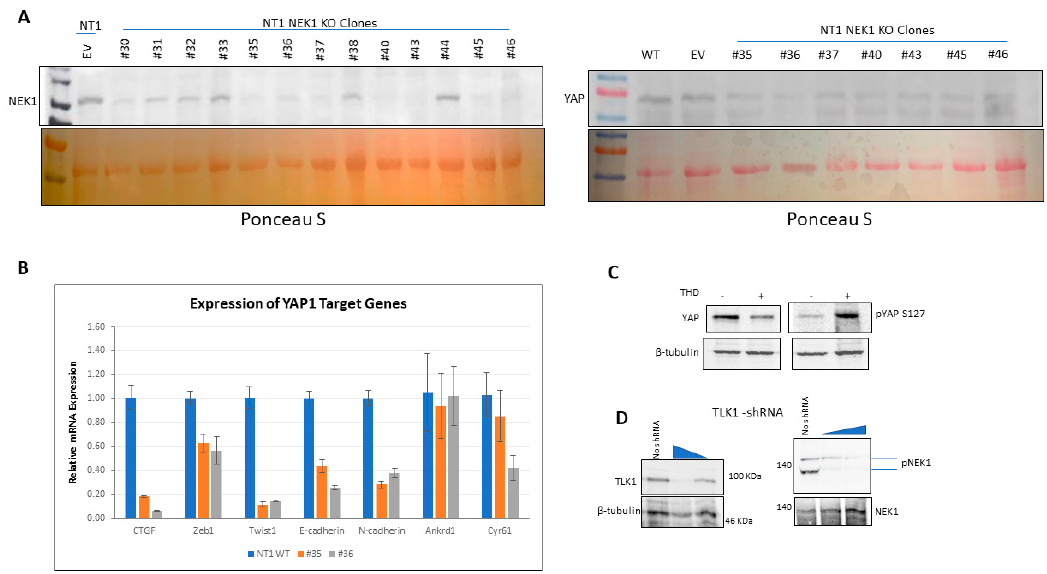
Figure 2. ( A ) CRISPR / Cas9-mediated loss of NEK1 resulted in reduced levels of YAP protein, possibly due to instabilization (EV = empty vector). ( B ) Expression of several typical YAP target genes is reduced in NEK1 KO clones. GAPDH mRNA was used as an internal control. ( C ) Treatment of LNCaP cells with THD, a specific inhibitor of TLKs, resulted in reduced YAP protein level and conversely in its S127 hyperphosphorylation. ( D ) Reduction of TLK1 expression via (short hairpin) shRNA transfection led to loss of pNEK1-T141.